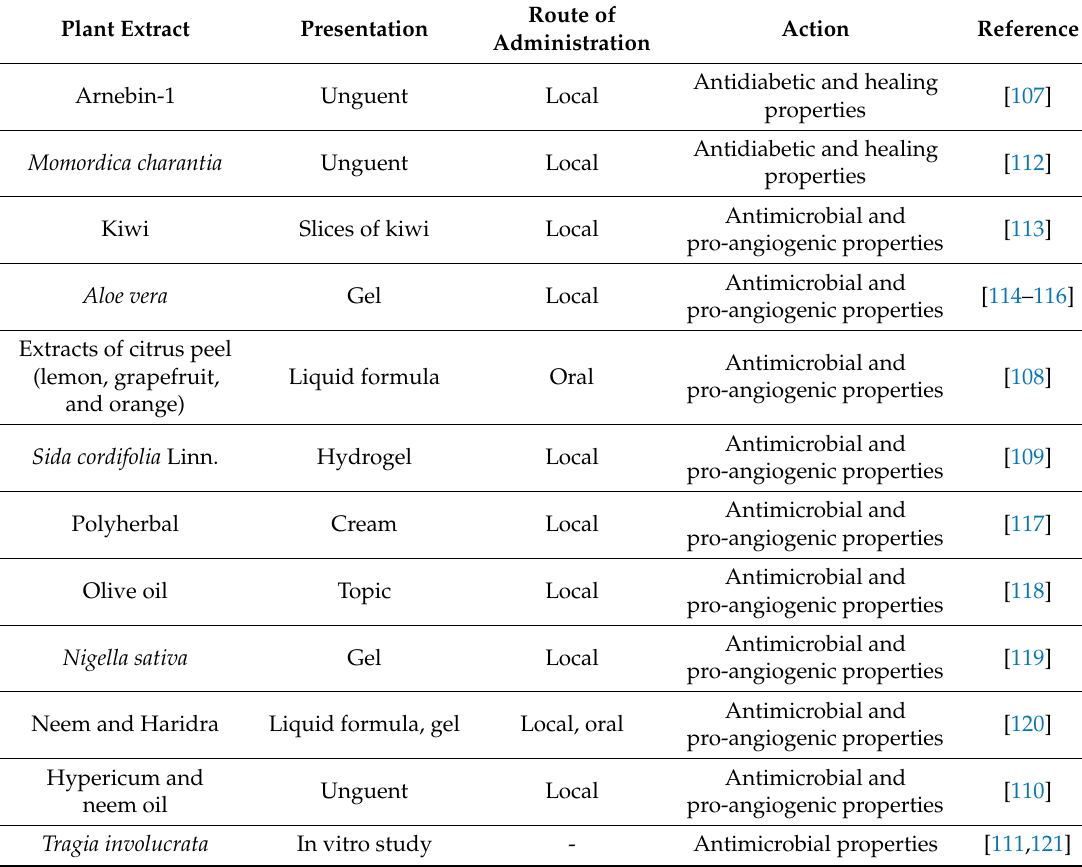
Table 8. Plant extracts used in wound repairing for the treatment of DFU infections. Plant